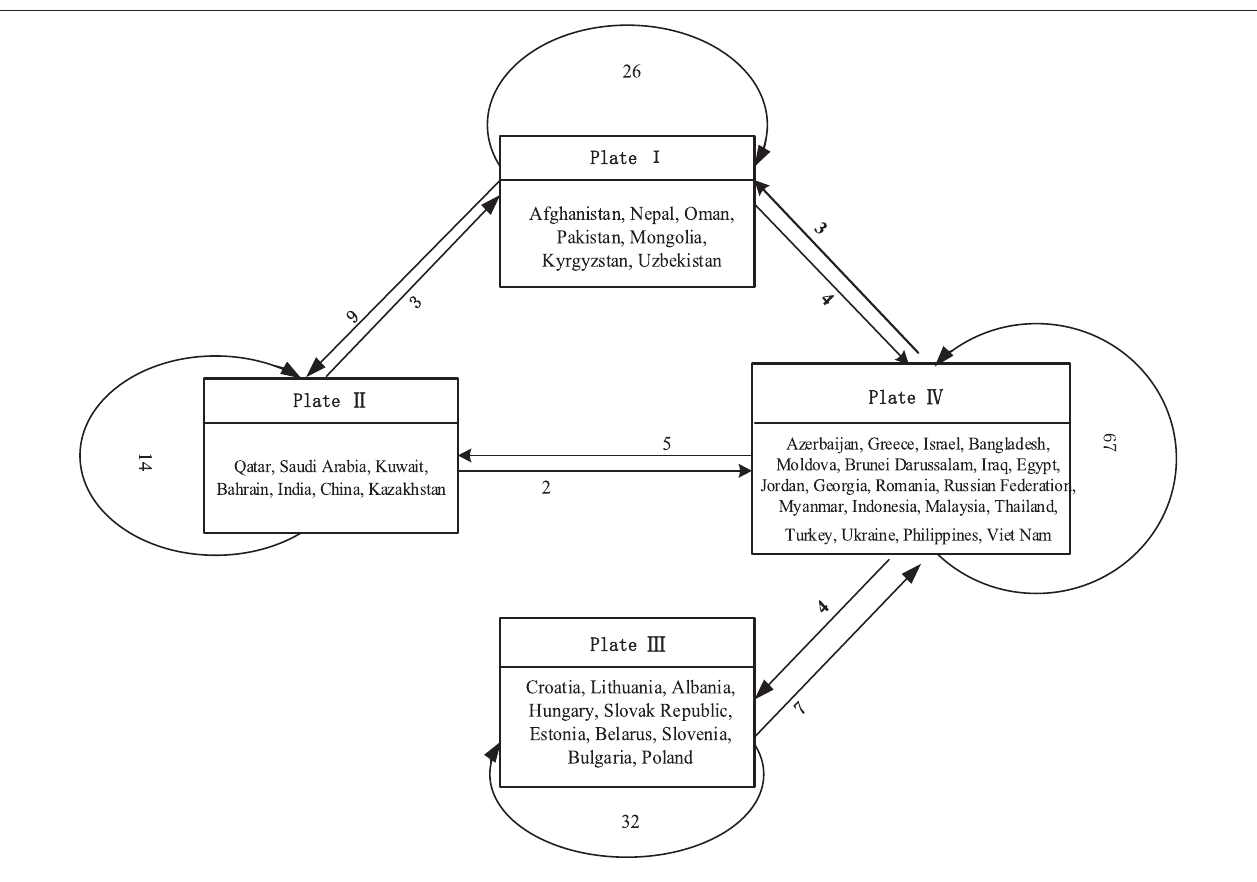
FIGURE 5 | Contagion relationship of environmental risk between the four major plates.